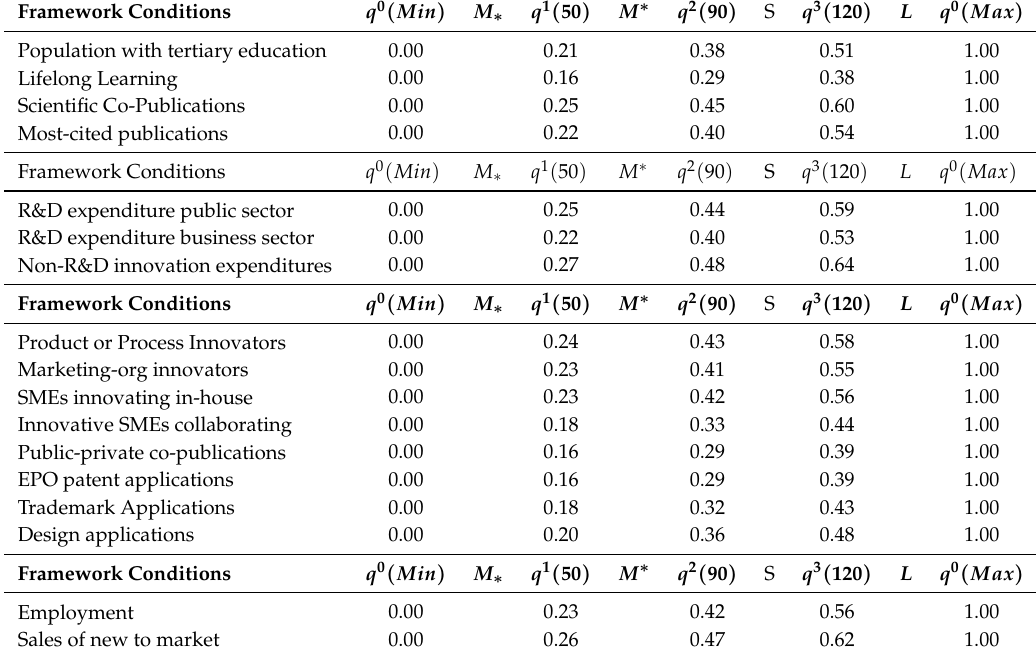
Table 1. Reference Levels of the Regional Innovation Index (RII) indicator in 2019, relative to the EU